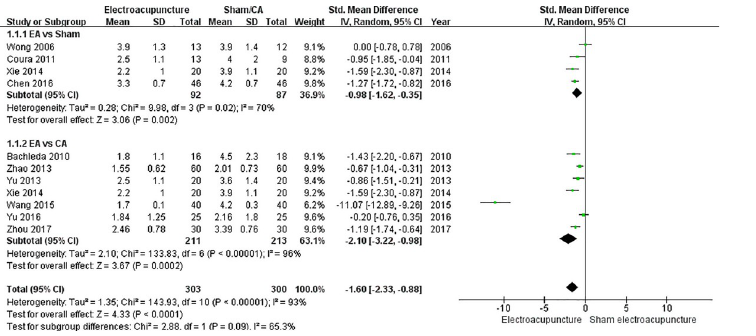
Fig 3. Forest plot of pain score 24 hours after surgery before sensitivity